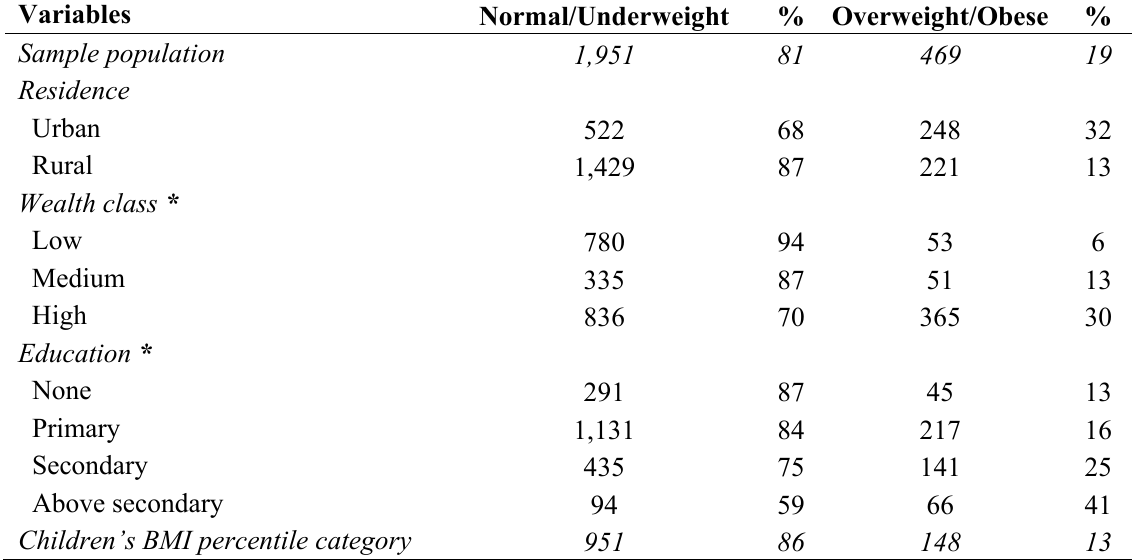
Table 1. Sociodemographic characteristics and weight status of the sample of adult females ( N = 2,420) and children ( N = 1,099). Statistically significant differences were observed for all sociodemographic characteristics between normal/underweight and overweight/obese groups; * An asterisk indicates a statistically significant trend ( p <